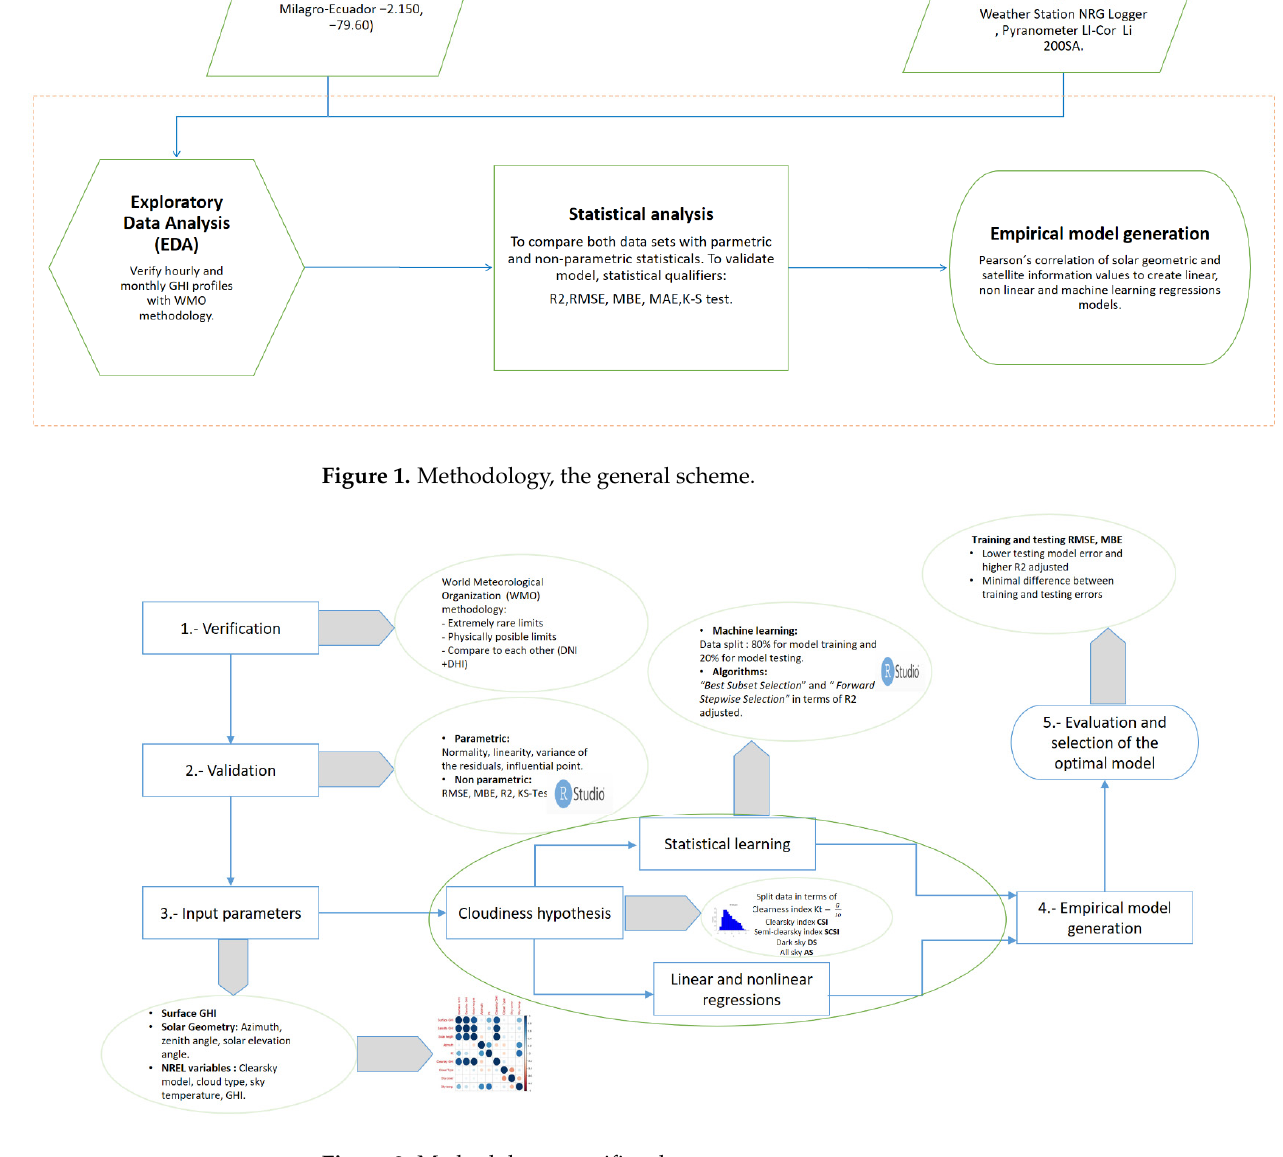
Figure 2. Methodology, specific scheme .